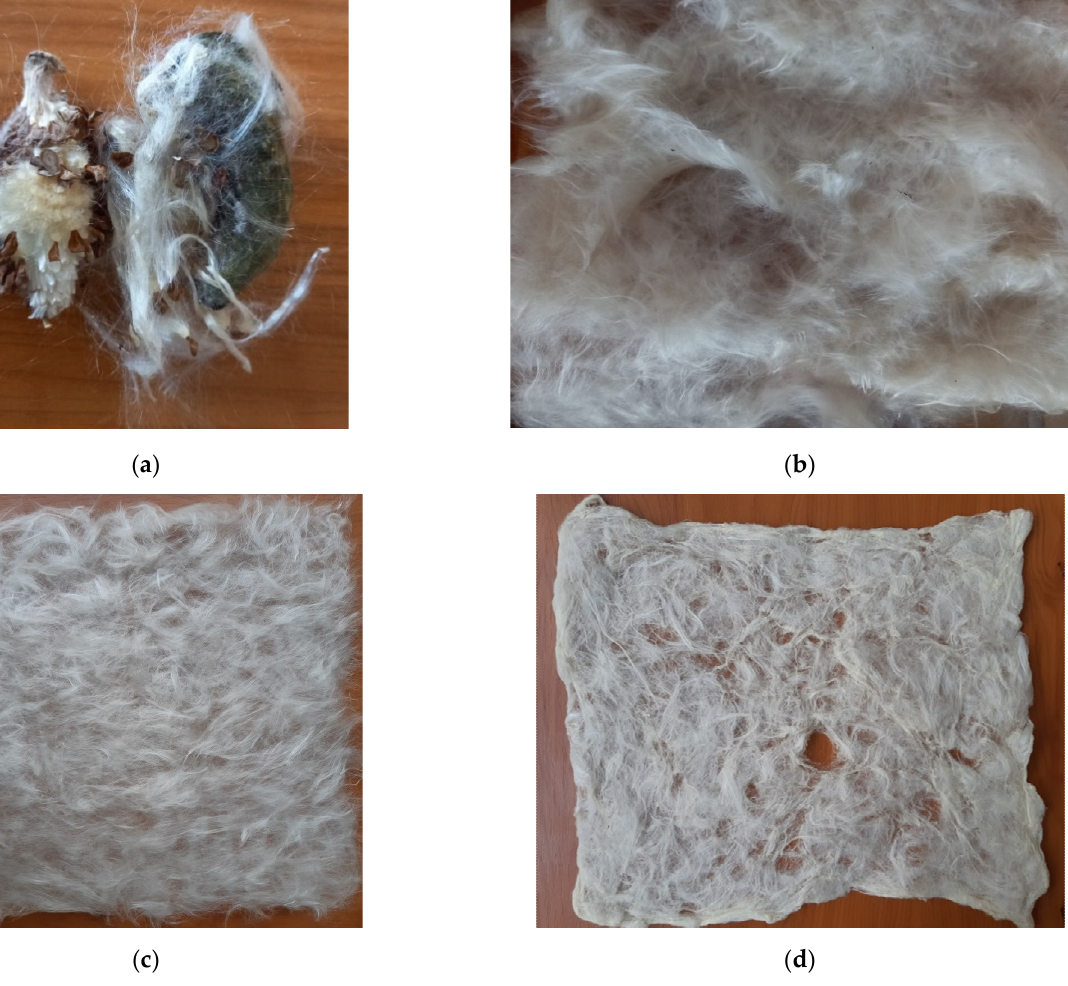
Figure 2. Calotropis procera fibres: ( a ) mature fruits; ( b ) extracted fibres arranged to form a thin sheet for composite layer; ( c ) untreated Calotropis sheet; ( b ) treated Calotropis sheet.